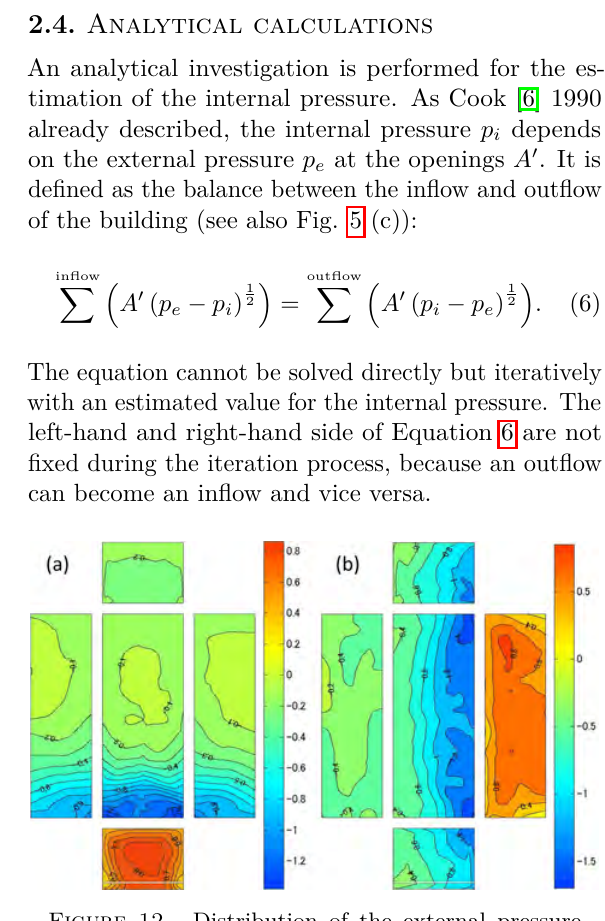
Figure 10. Numerical results for the internal pressure coefficients c pi : (a) case 1, (b) case 2, (c) case 3, (d) case 4, (e) case 5 and (f) case 6.